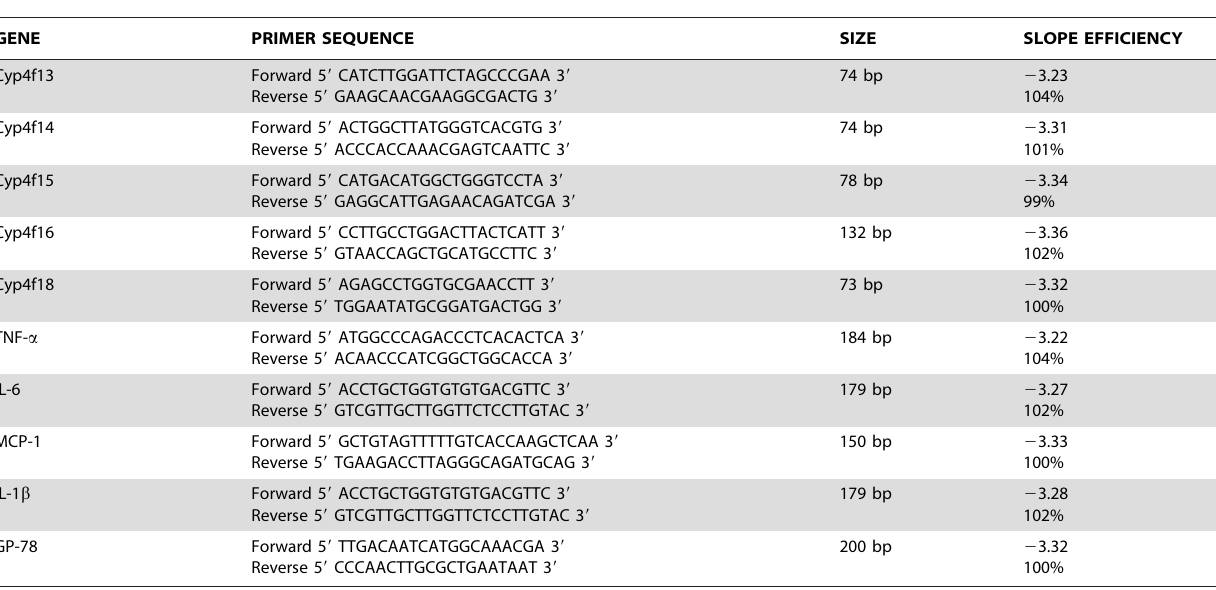
Table 1. LIST OF PRIMERS USED FOR QRT-PCR.